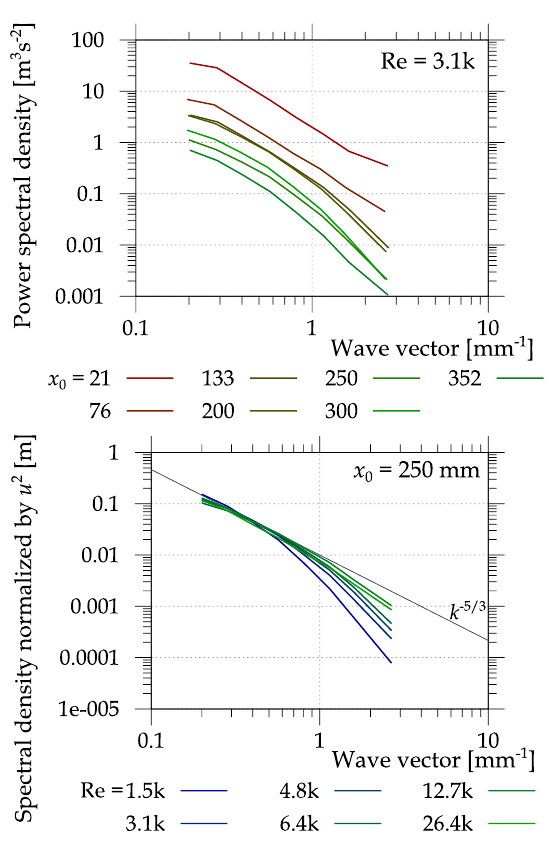
Fig. 7. Top left : example of the instantaneous velocity field colored by the energy (i.e. half of square of velocity magnitude). Middle left : the same data with highlighted fluctuations of size interval from σ l = 0 . 5 to σ h = 0 . 7mm. Middle right : from σ l = 1 . 5 to σ h = 2 . 0mm. Bottom left : from σ l = 3 . 9 to σ h = 5 . 9mm. Bottom right : Length-scale dependent fluctuations, red colors correspond to smallest length-scales, green to middle scales and blue to largest scales. The Reynolds number is 3 . 1 · 10 3 , the left side of the panels is 21mm from the grid.